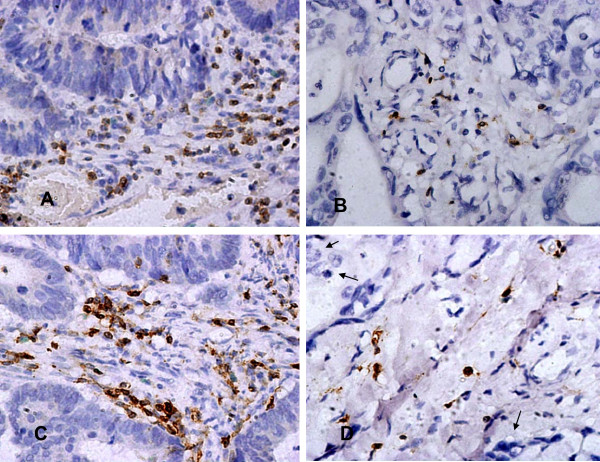
Patterns of TILs within stage IIIB colon cancer tissues. A high density of CD3+ cells infiltrated into the colon cancer stroma (×400, A), a low density of CD3+ cells infiltrated into the colon cancer stroma (×400, B), a high density of CD45RO+ cells infiltrated into the colon cancer stroma (×400, C), and a low density of CD45RO+ cells infiltrated into the colon cancer stroma (×400, D, "↑"refers to tumor tissue). All of the antigens were immunolocalized to the membrane.